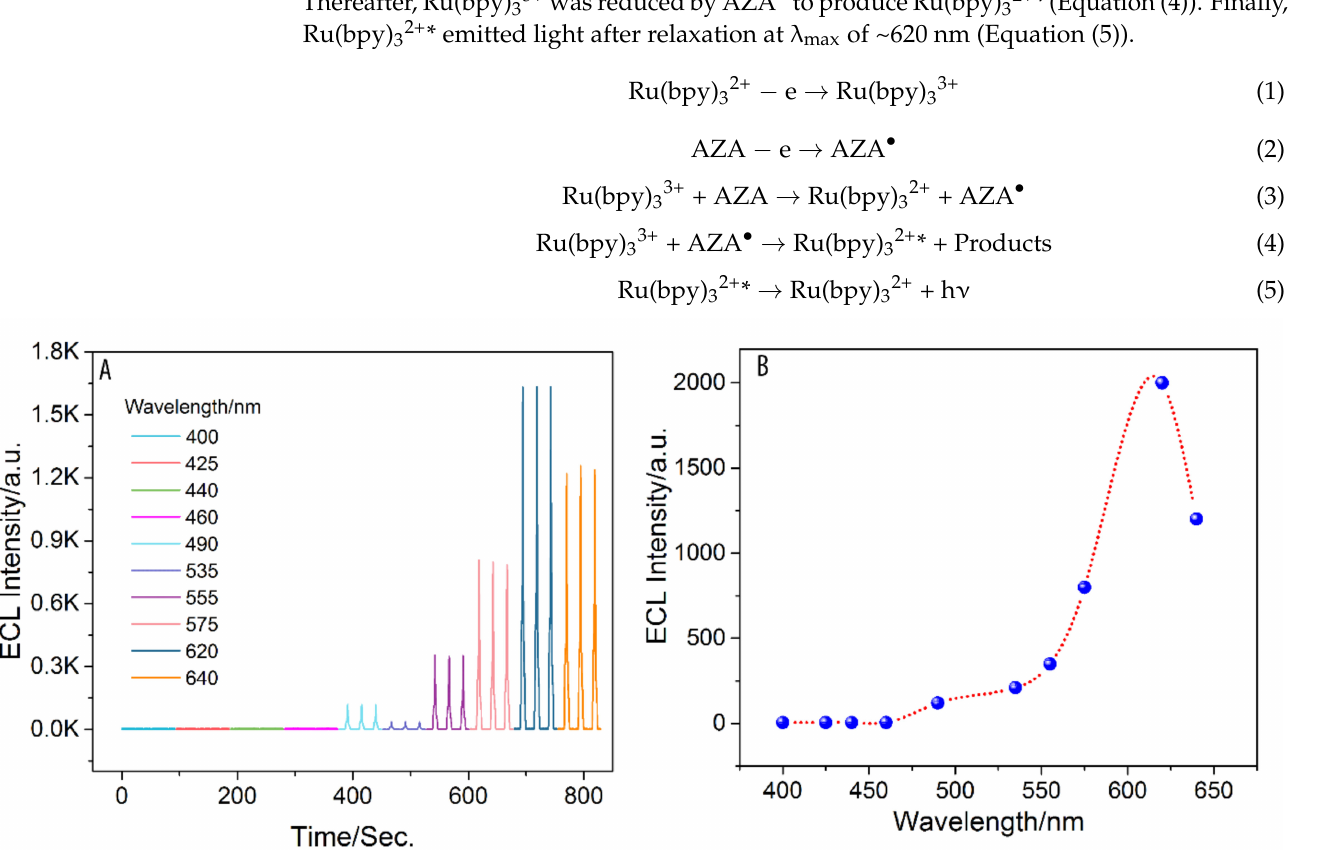
Figure 3. ( A ) Profile of ECL signal–time curve and ( B ) ECL emission spectrum of Ru(bpy) 32+ /AZA sensor. The spectrum was recorded in the presence of 0.5 mM Ru(bpy) 32+ and 1 mM AZA in 0.1 M PBS (pH 8.5); PMT = 900